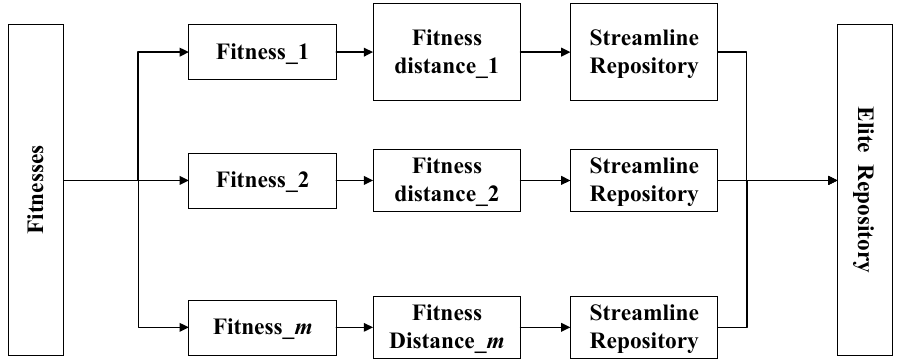
Figure 2. Schematic diagram of repository update mechanism based on fitness distance.